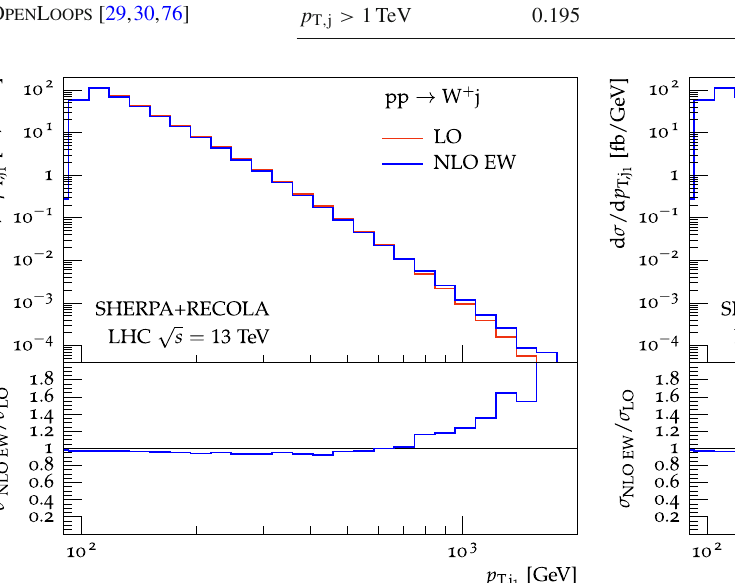
additional cut (cid:5)(cid:12)( j , j ) < 3 π/ 4. The lower panels display the ratio